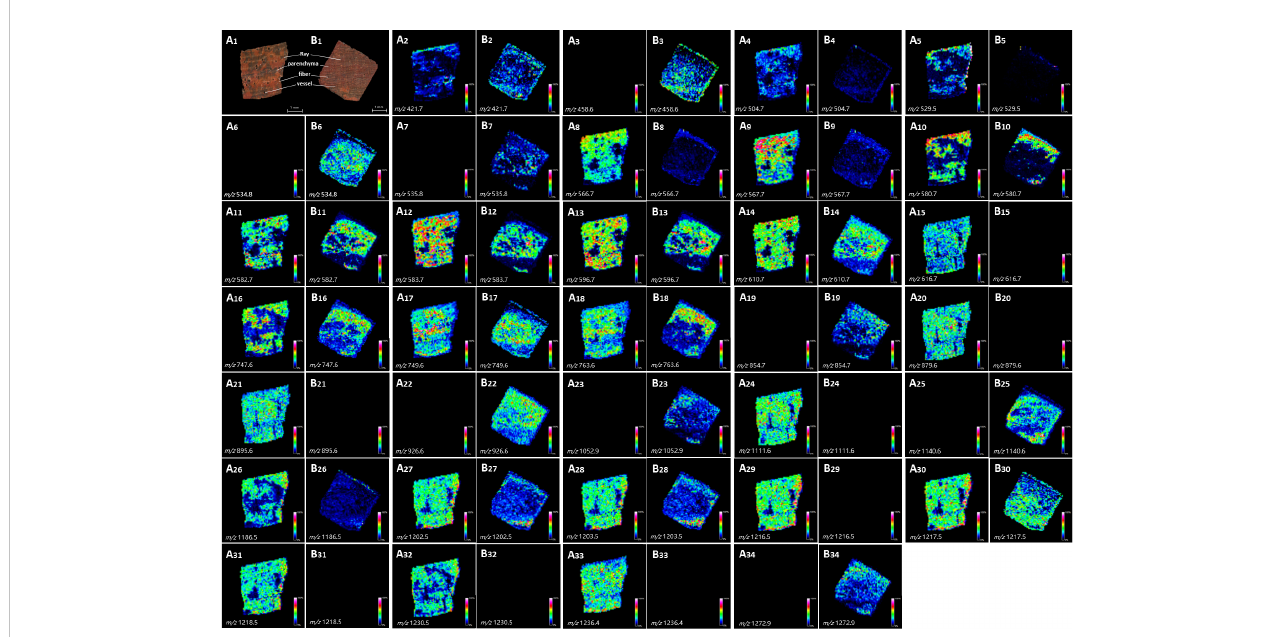
FIGURE 3 Optical images of tissue sections and localization modes of metabolite ions in wood slices of P. santalinus and P. tinctorius with signi fi cant differences. (A1, B1) , optical images of tissue section of P. santalinus and P. tinctorius , respectively, including four main types of tissue cells. (A2 – A34 , B2 – B34) , localization modes of metabolite ions in wood slices of P. santalinus and P. tinctorius , respectively.